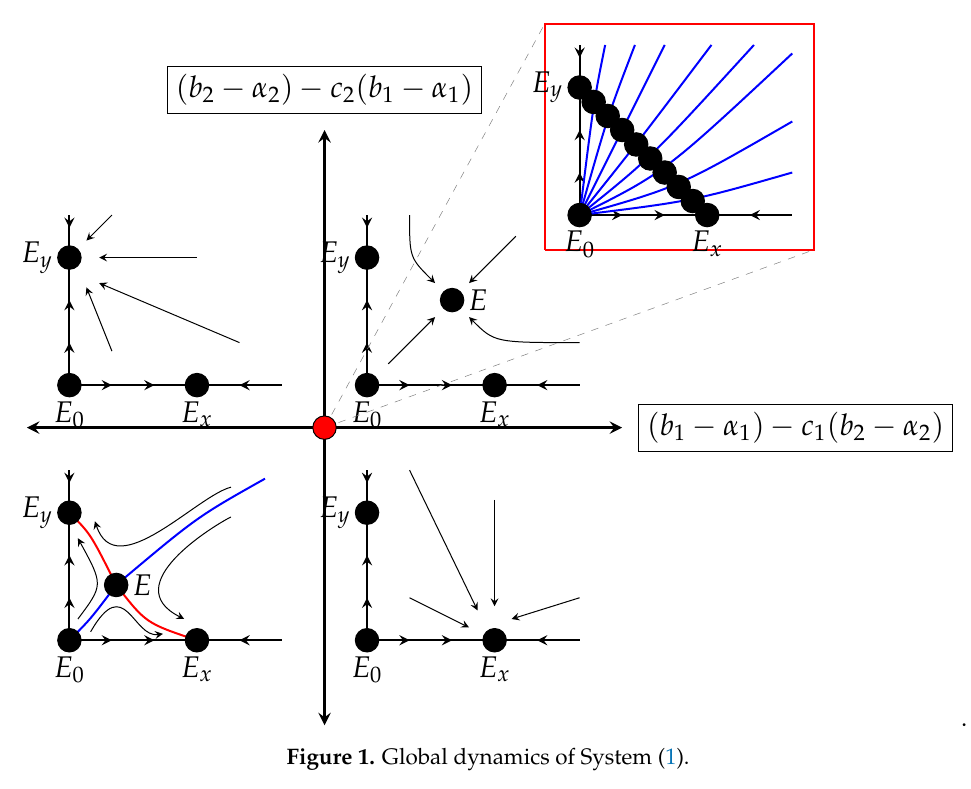
Figure 1. Global dynamics of System